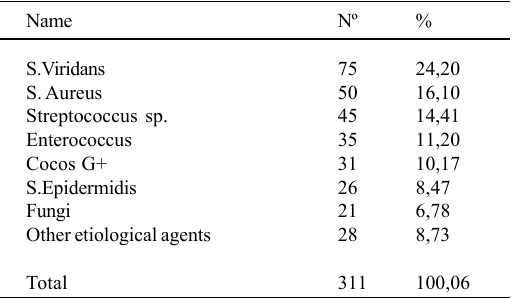
Table 1. Active infectious endocarditis: surgical treatment Identified etiological agents Name